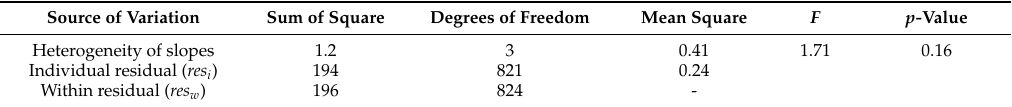
Table 8. Computation heterogeneity of slopes for test laboratories